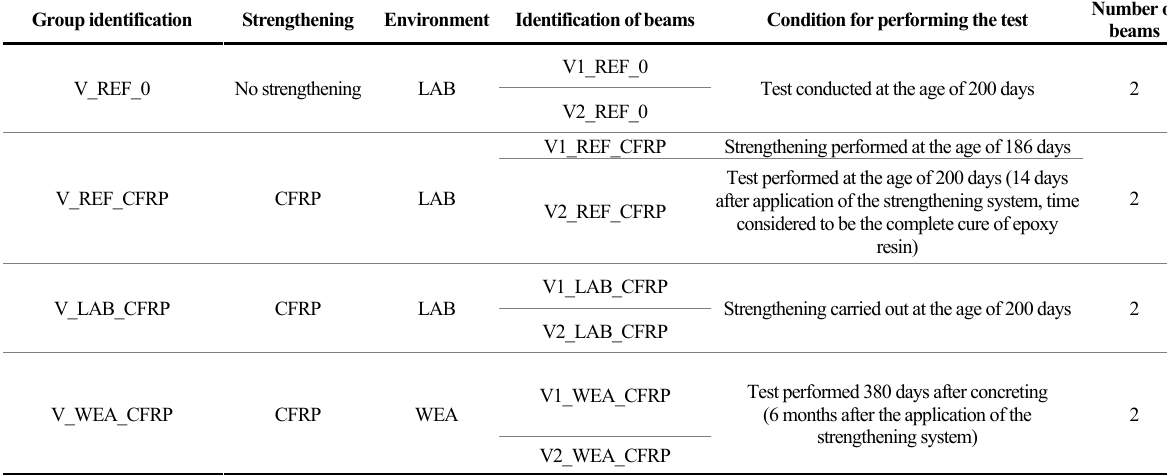
Table 3 Test program for reinforced concrete beams Group